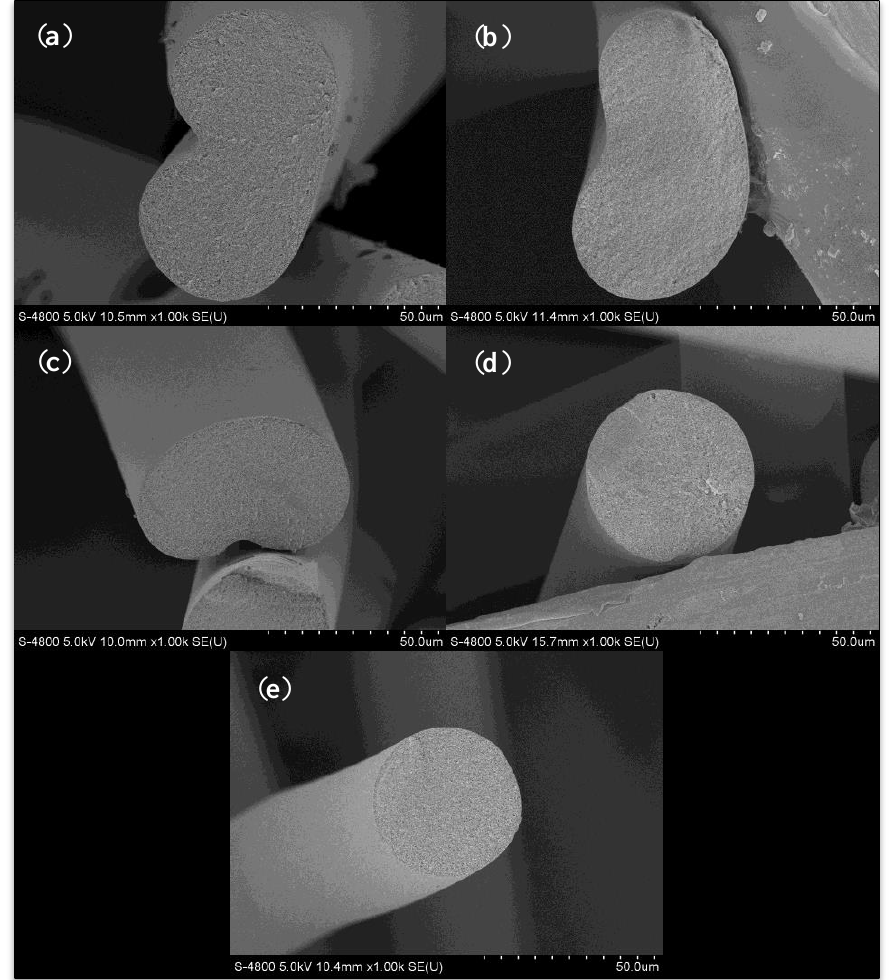
Figure 5. SEM images of freeze-dried, cryo-fractured fiber from the coagulation bath (sampling point I) at varying coagulation bath concentrations (DMAc/H 2 O). ( a ) 57.8 wt%; ( b ) 62.1 wt%; ( c ) 66.6 wt%; ( d ) 72.2 wt%; ( e ) 79.0